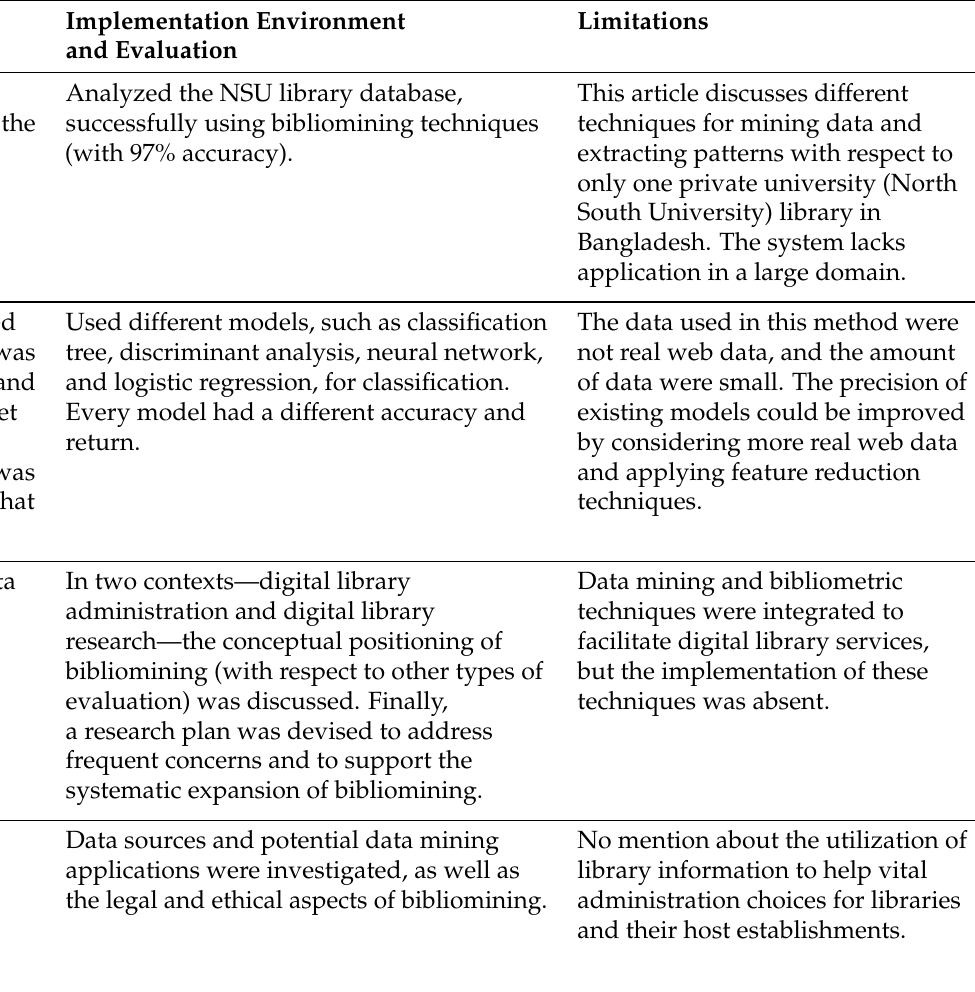
Table 4. Summary of the research on